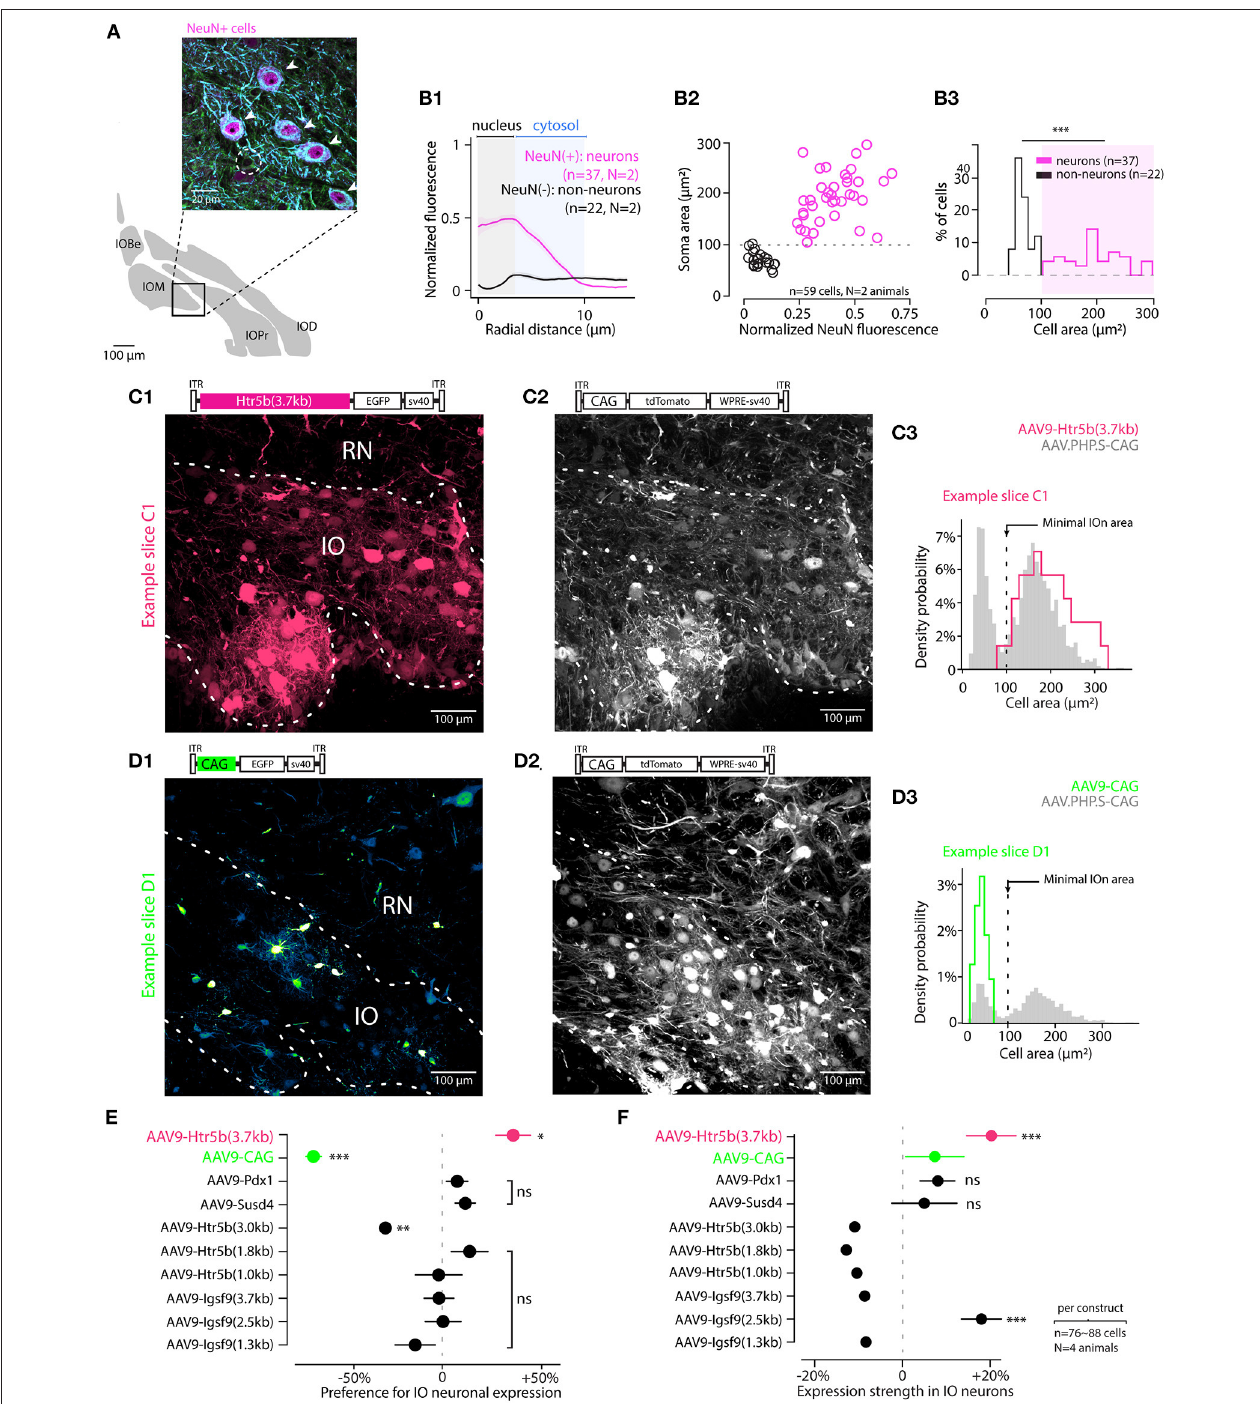
FIGURE 2 | Screening viral constructs for specific expression in IO neurons over astrocytes. (A) Identifying IO neurons and astrocytes in triple-antibody-labeled slices. The neurons are identified with NeuN and MAP2 immunoreactivity (purple and blue channels; somata indicated with arrowheads in the enlarged section of confocal image). Astrocytes are only labeled with α -Tubulin (green; cell soma indicated with a dashed line). (B) Using NeuN staining as a criterion for defining cells as neurons as opposed to non-neurons based on soma area. (B1) Averaged radial NeuN staining intensity plots for cells classified as neurons or non-neurons (normalized somatic NeuN >or <than 20%, respectively). The shaded regions highlight radial regions corresponding to the neuron nuclei (gray) and cytosol (blue). (B2) Scatter plot showing the relationship between cell soma area and the normalized NeuN staining intensity for neurons (purple) and astrocytes (black). Dashed line indicates